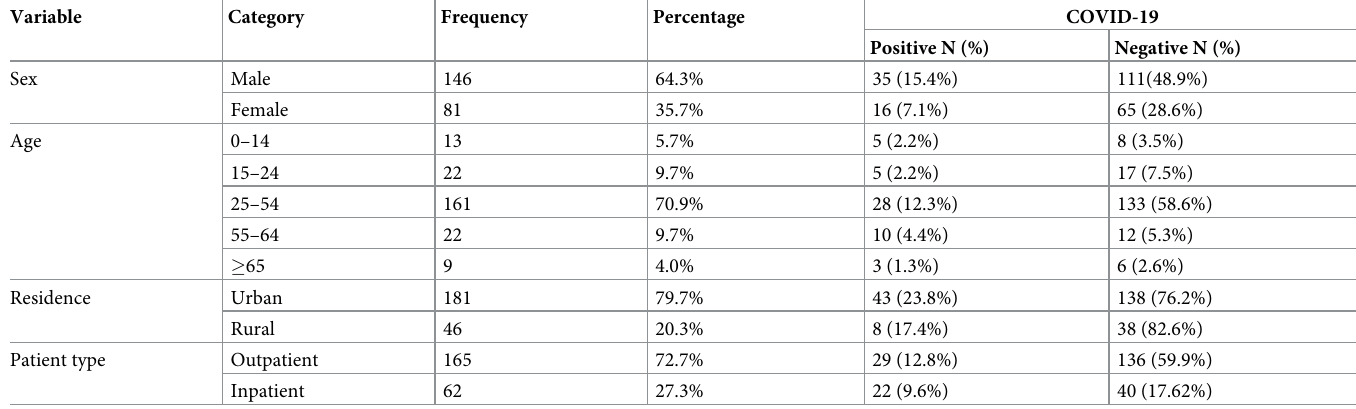
Table 1. Demographic characteristics of study participants for comparative evaluation of saliva and NPS for SARS-CoV-2 detection using RT-qPCR among COVID-19 suspected patients at Jigjiga, Eastern Ethiopia.